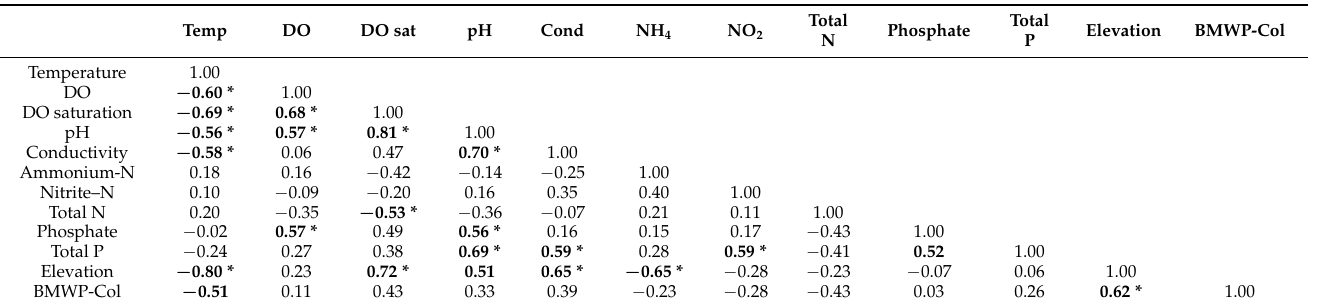
Table A2. Spearman’s rank correlation matrix of 11 environmental variables of the CRB and ARB dataset. * means significant correlations ( p < 0.05) and a moderate correlation (up to 0.5) are marked in bold.